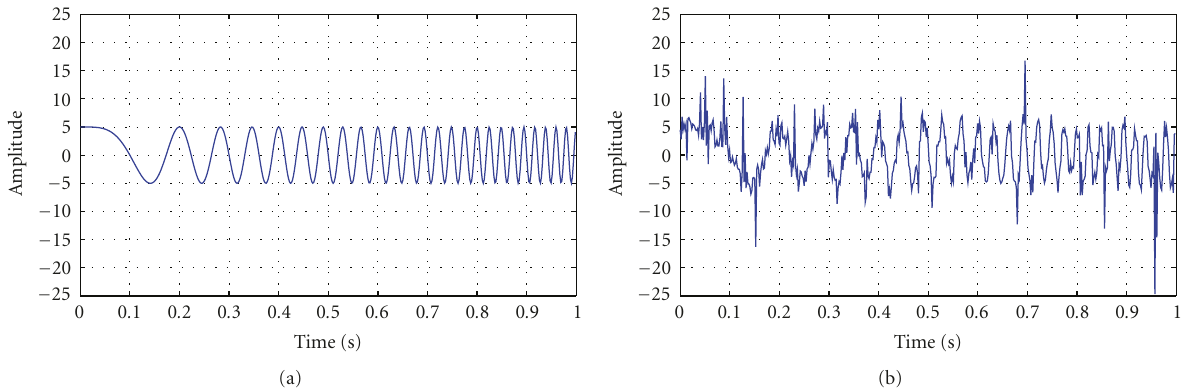
Figure 9: The test noise-free FM signal s 2 ( n ) (a) and its realization corrupted by S α S noise with α = 1 . 5 and γ = 1